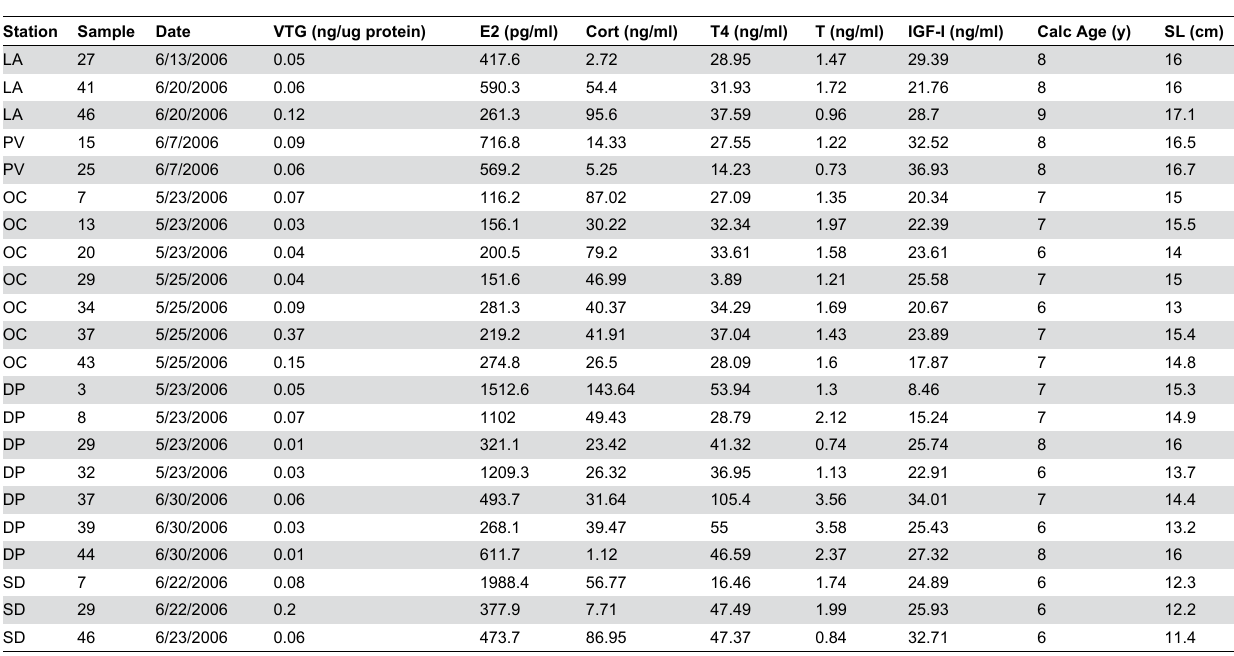
Table 1. Characteristics of male hornyhead turbot sampled.